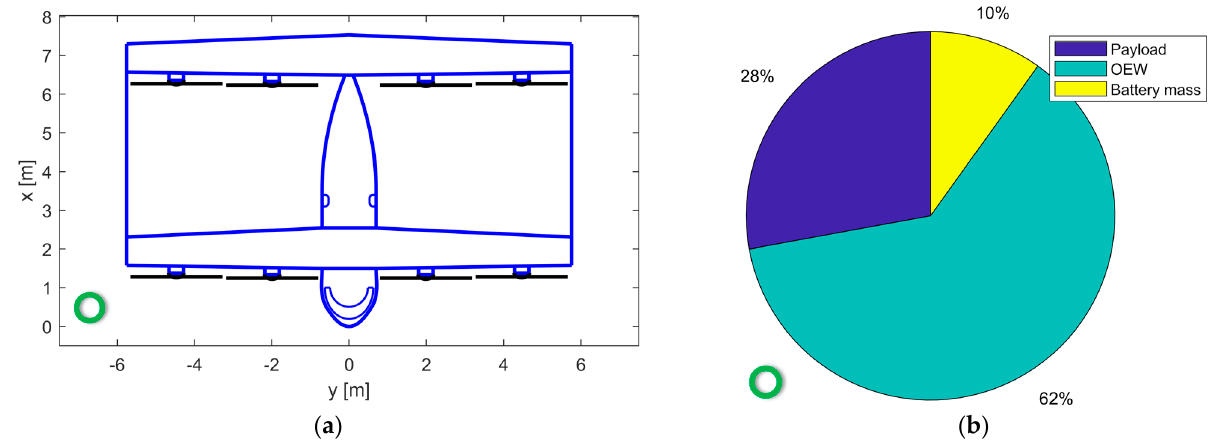
(b) Figure 19. Selection of the configuration for different design missions: ( a ) single mission; ( b ) multi mission. For both, the